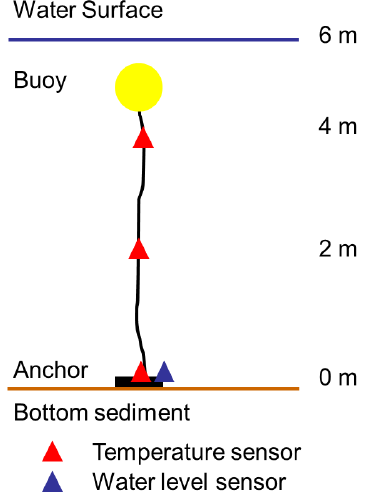
Figure 2. Schematic diagram showing the positions of sensors within the water column. To prevent freezing of the buoy within the ice cover (maximum 2m thick), sensors were deployed 2m be- low the water surface in most lakes. The water level sensor was located just above the bottom sensor, referred to in Figs. 4 and 5 as the “lowest sensor